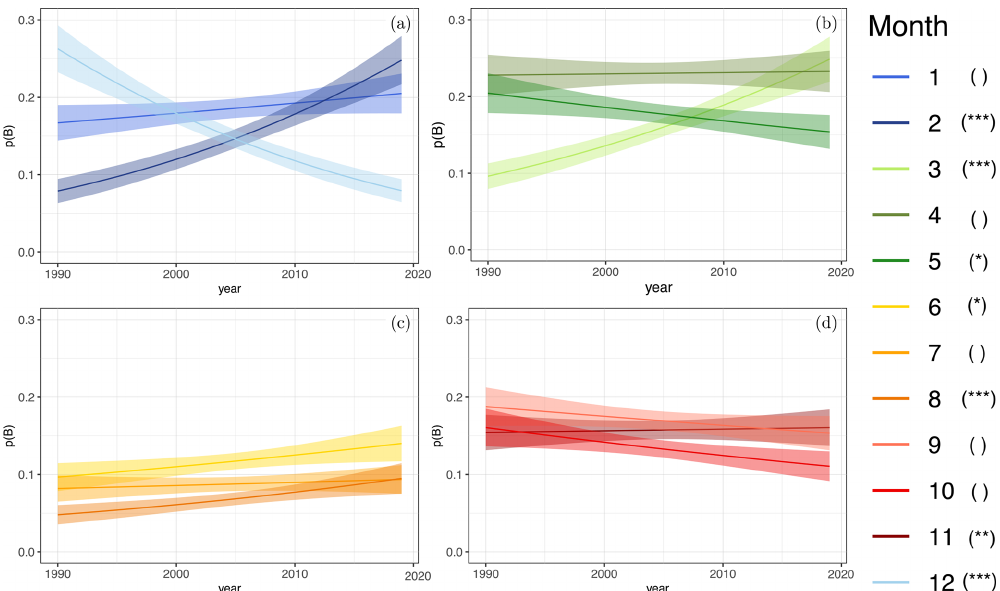
Figure 8. Blocking probability over time for individual month (Eq. 25). Shading shows 95% confidence intervals. (a) Winter (DJF), (b) spring (MAM), (c) summer (JJA) and (d) autumn (SON) in the Euro-Atlantic region (40 ◦ W–30 ◦ E). Significance is encoded as 0 < ( ∗∗∗ ) , < 0 . 001 < ( ∗∗ ) , < 0 . 01 < ( ∗ ) , < 0 . 05 < () .